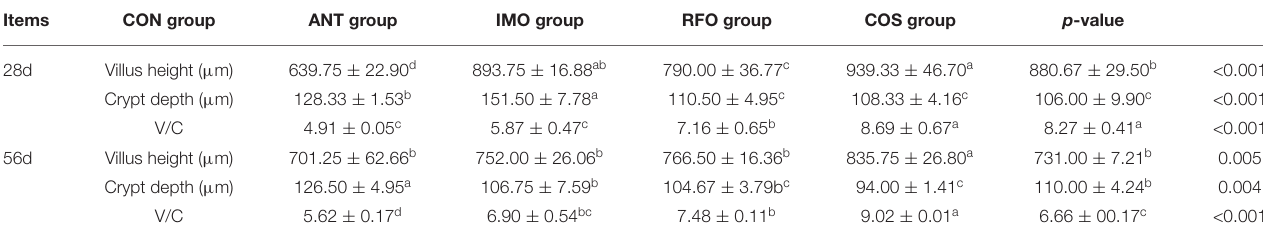
TABLE 5 | Effect of different oligosaccharides on ileum morphology of